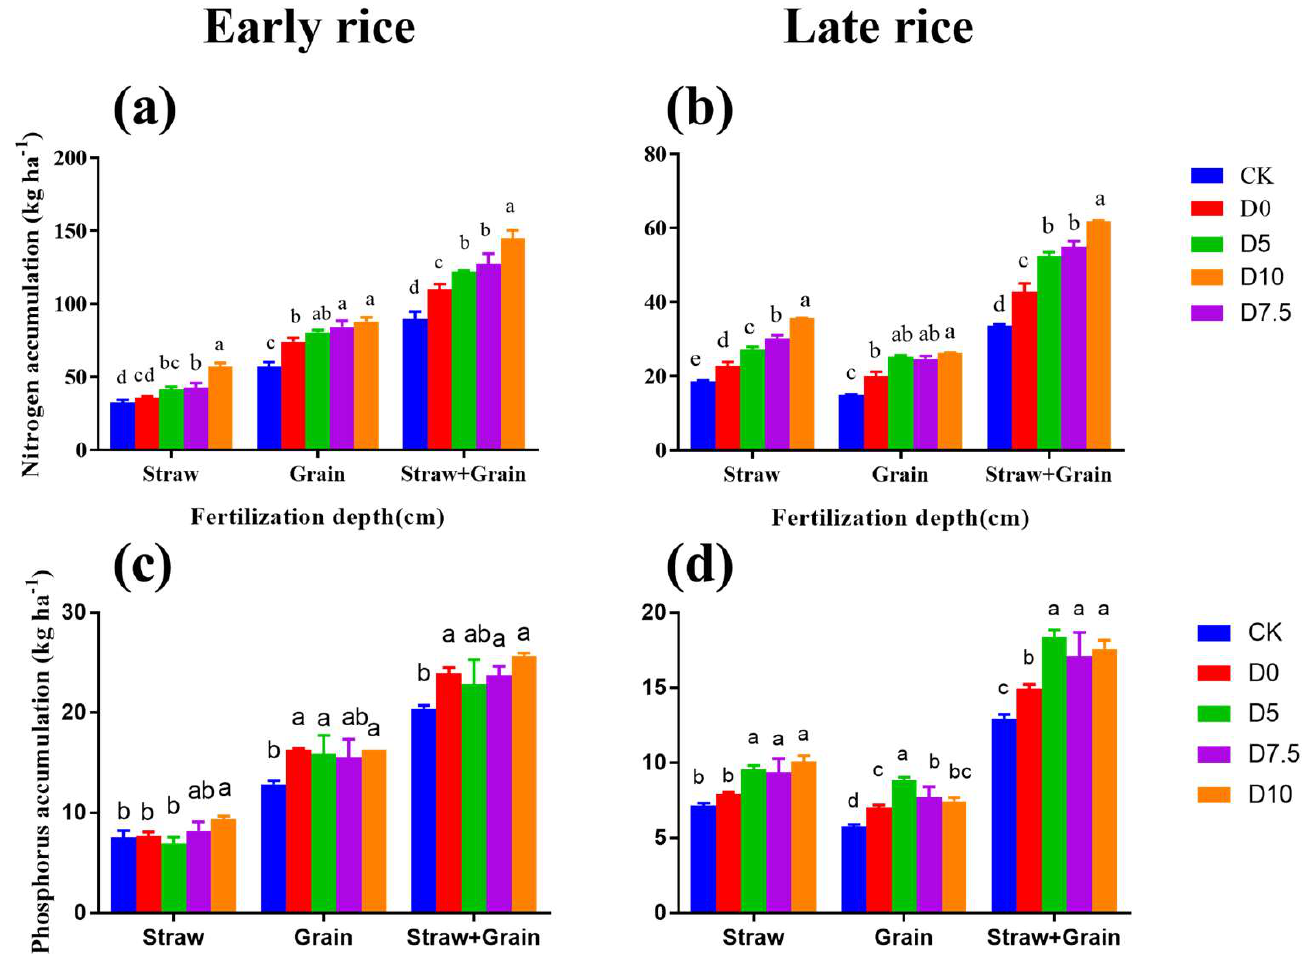
Figure 3. Nitrogen and phosphorus accumulation in different parts of early rice and late rice under different fertilization depths. ( a ): Nitrogen accumulation in different parts of early rice; ( b ): Nitrogen accumulation in different parts of late rice; ( c ): Phosphorus accumulation in different parts of early rice; ( d ): Phosphorus accumulation in different parts of late rice. CK: no fertilizer; D0: surface spreading; D5: 5 cm side−deep fertilization; D7.5: 7.5 cm side−deep fertilization; D10: 10 cm side−deep fertilization. Different lowercase letters in the figure indicate significant difference among treatments at P = 0.05 (LSD).